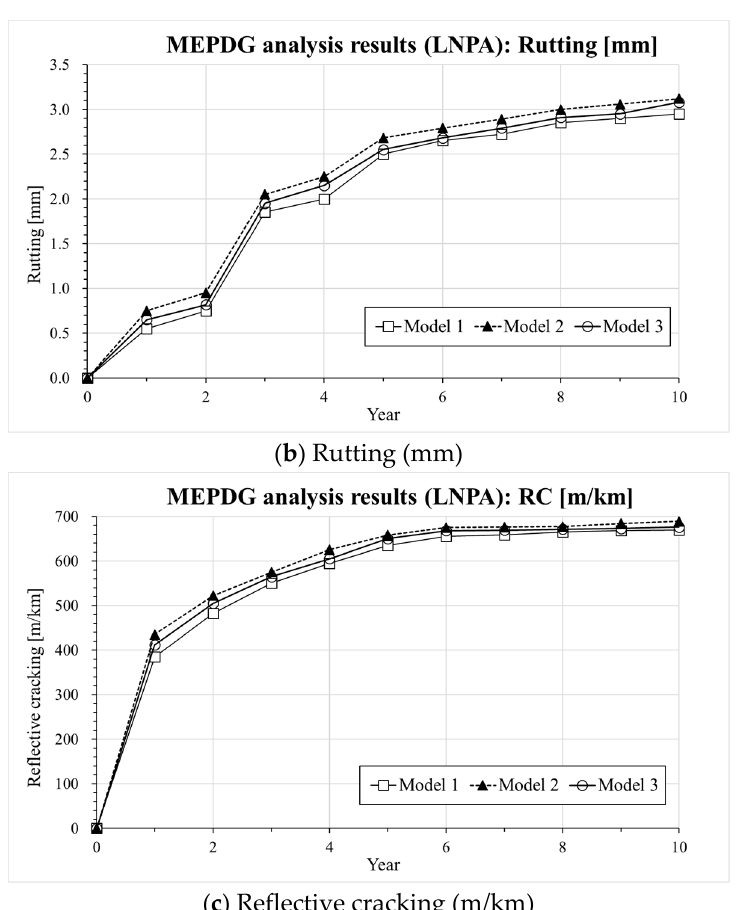
Figure 7. Results of AASHTOWARE analysis for Mixture 3 (LNPA): ( a ) IRI, ( b ) Rutting, ( c ) Reflective cracking.